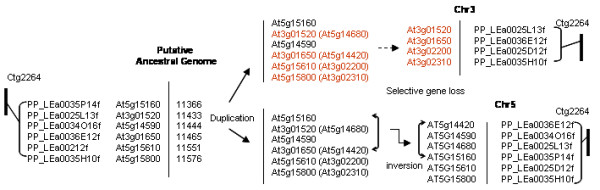
Proposed evolutionary steps involving some syntenic blocks between Arabidopsis and Peach genomes. Blocks in the putative ancestral Arabidopsis genome and Arabidopsis chromosome 3 and 5 that match to the same peach BAC contig are illustrated. Red colors were used to help track the genes. The order of the ESTs in the BAC contig was not shown because the ESTs were anchored to overlapping BACs.